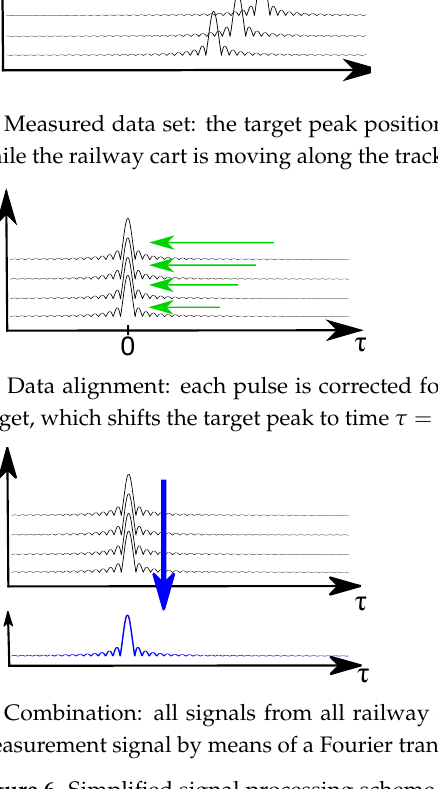
Figure 6. Simplified signal processing scheme for retrieving the target echo: ( a ) recorded data, ( b ) data alignment, and ( c ) combination